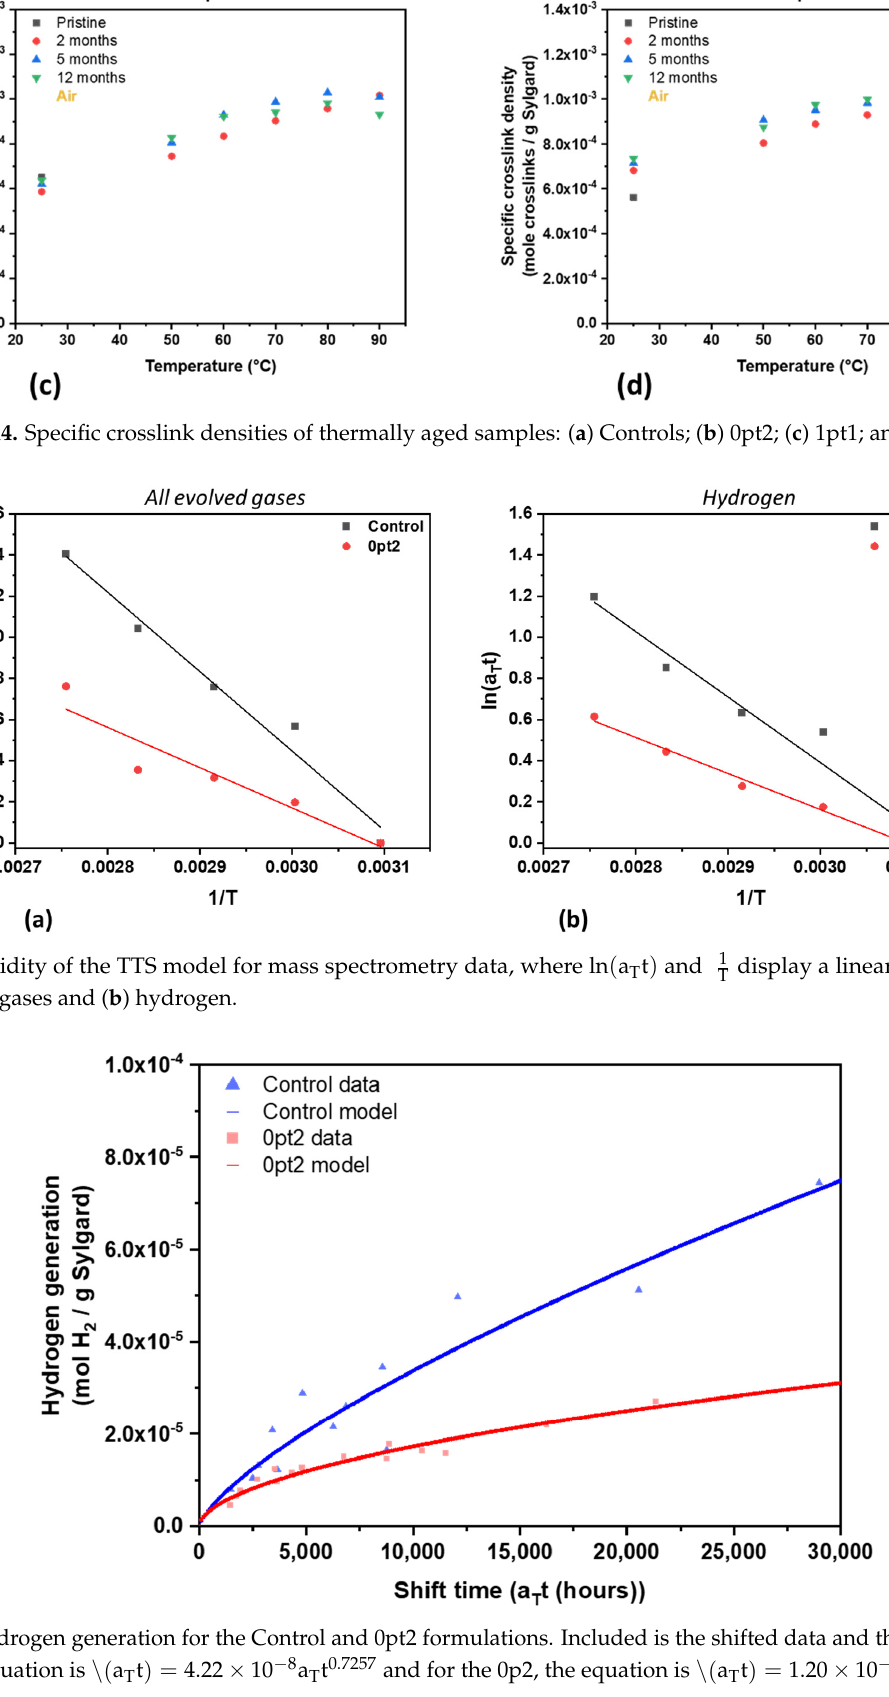
Figure A6. Hydrogen generation for the Control and 0pt2 formulations. Included is the shifted data and the model. For the Control, the equation is 𝓃(cid:4666)a (cid:2904) t(cid:4667) = 4.22 (cid:3400) 10 (cid:2879)(cid:2876) a (cid:2904) t (cid:2868).(cid:2875)(cid:2870)(cid:2873)(cid:2875) and for the 0p2, the equation is 𝓃(cid:4666)a (cid:2904) t(cid:4667) = 1.20 (cid:3400) 10 (cid:2879)(cid:2875) a (cid:2904) t (cid:2868).(cid:2873)(cid:2871)(cid:2877)(cid:2869) .